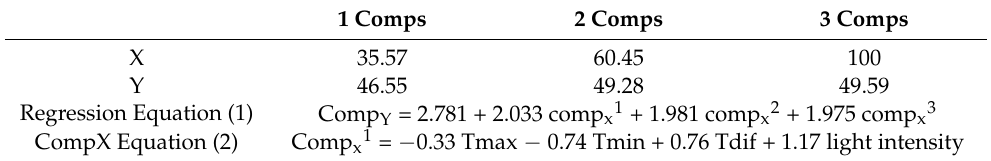
Table 2. PLS regression model of effects of meteorological factors on flavonoid content of Tartary